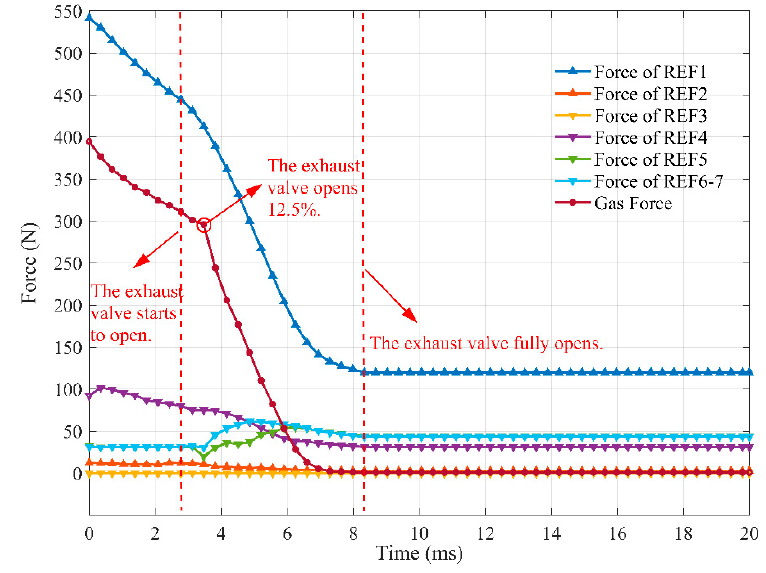
10 of 17 Figure 8. Comparison chart of the in-cylinder pressure. The area and pressure of each refined region can be obtained on the basis of surface slices and 3D simulation results. The integral method was used to calculate the gas force of the exhaust valve during the exhaust stroke according to Equation (8).